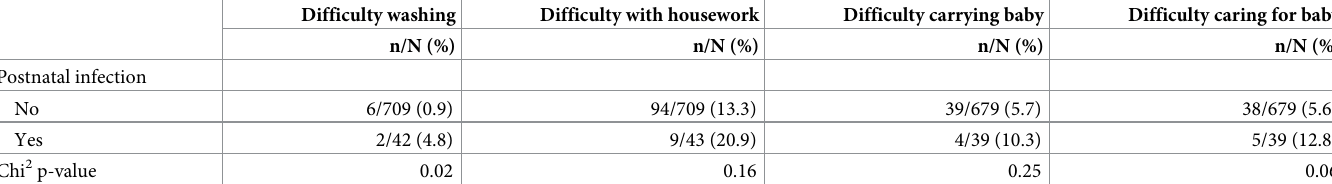
Table 7. Associations between early maternal postnatal infection (day 0–7) and maternal function at day